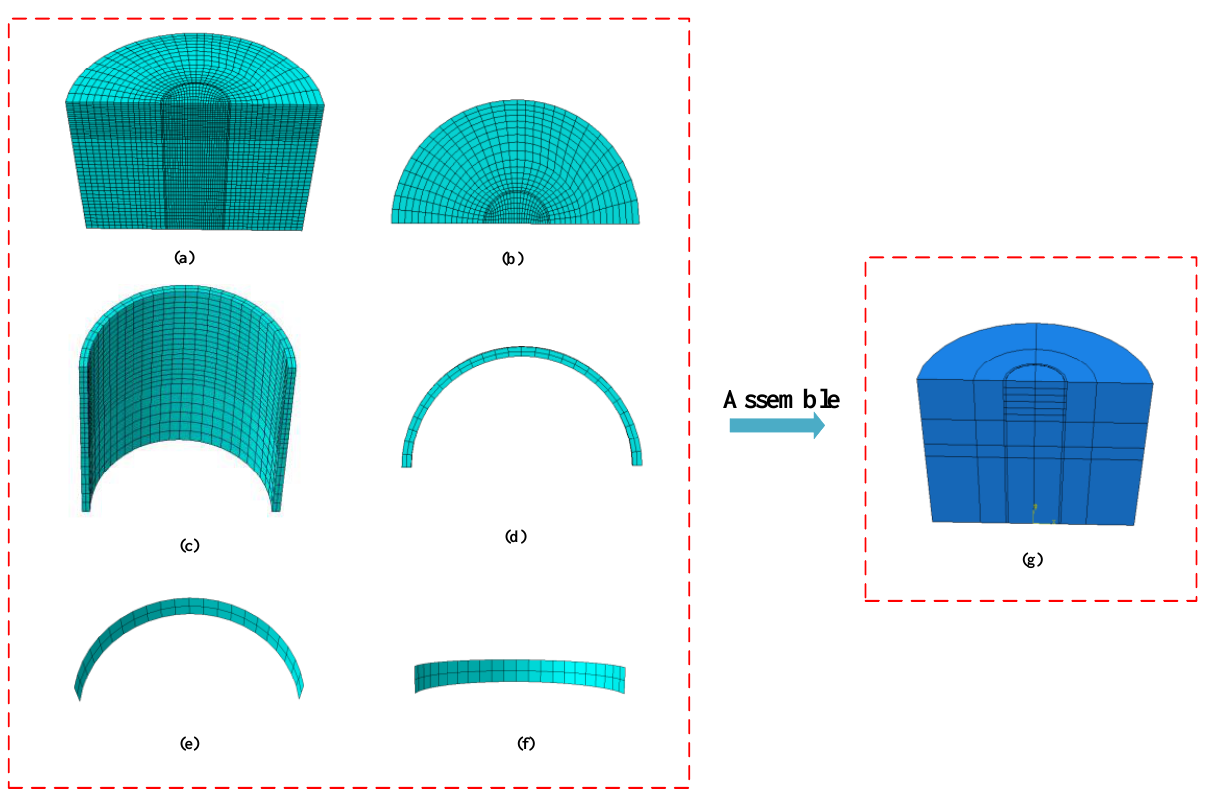
Figure 7. Model assembly renderings: ( a ) overall view of soil model; ( b ) top view of soil model; ( c ) overall drawing of underground diaphragm wall; ( d ) top view of underground diaphragm wall; ( e ) overall drawing of lining wall; ( f ) front view of lined wall; ( g ) model assembly renderings .